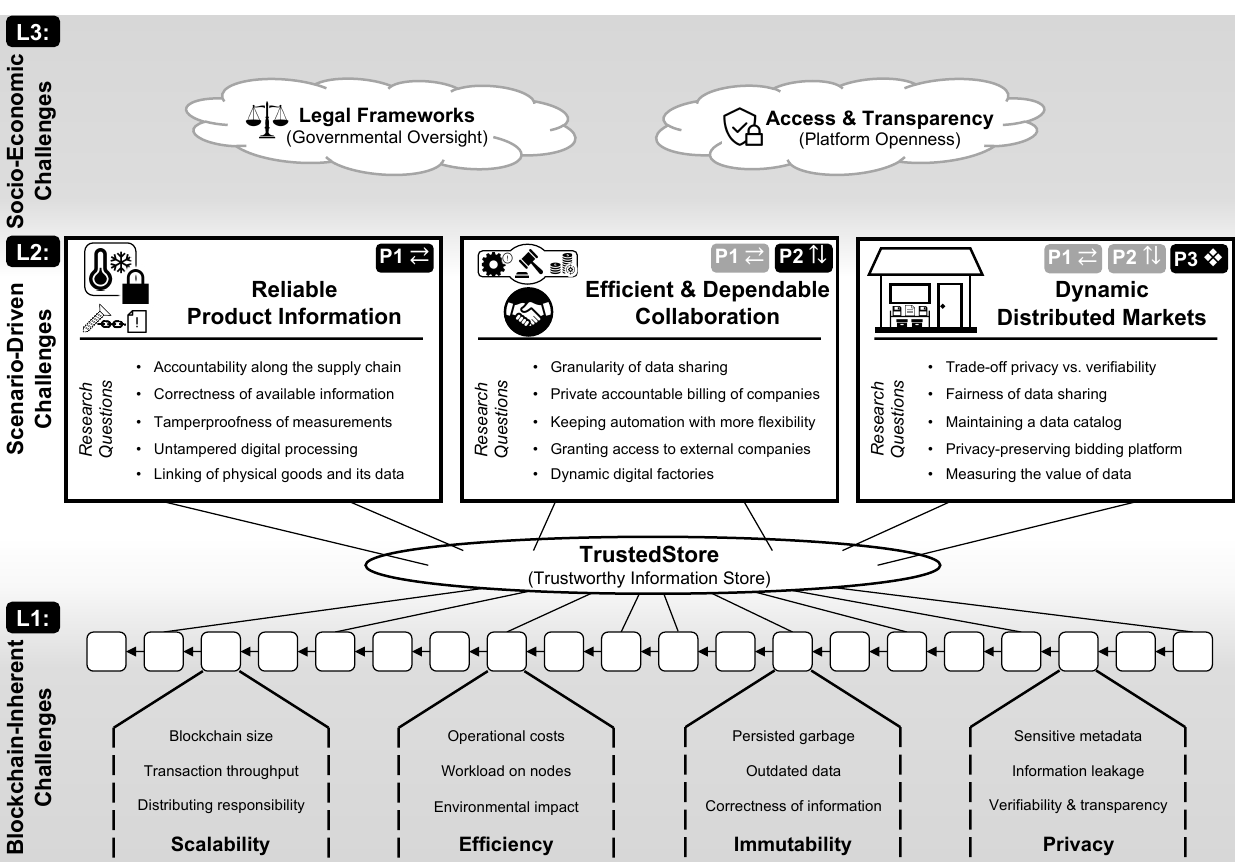
Figure 2. We group our research towards accountable and dependable manufacturing into three layers (from bottom to top). L1 : Blockchain-inherent challenges that concern the properties of blockchain technology, which is expected to serve as an underlying key component of our envisioned TrustedStore. L2 : Scenario-driven challenges that can be grouped into three main research directions that each focus on a specific research pillar, i.e., along supply chains (P1 Õ ), across supply (cid:118) chains (P2 Ö ), and situations with insufficient trust between stakeholders (P3 ). L3 : Socio-economic challenges that have an impact on underlying collaborations and improvements. To offer viable solutions for accountable and dependable manufacturing, research must consider and tackle all layers and their individual research